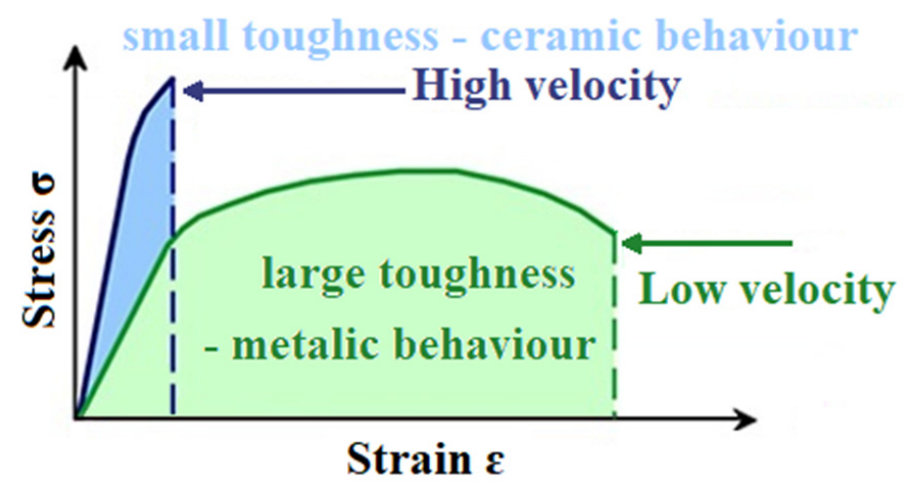
Figure 3. Schematic representation of dual character materials in correlation with the particle velocity during the CS deposition process.